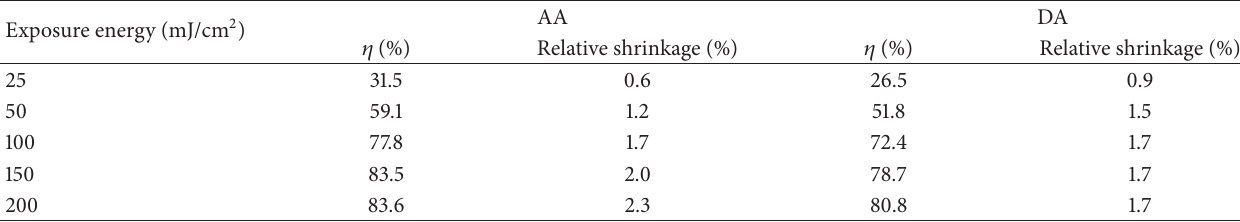
Table 3: 𝜂 and relative shrinkage for the AA and DA photopolymers.